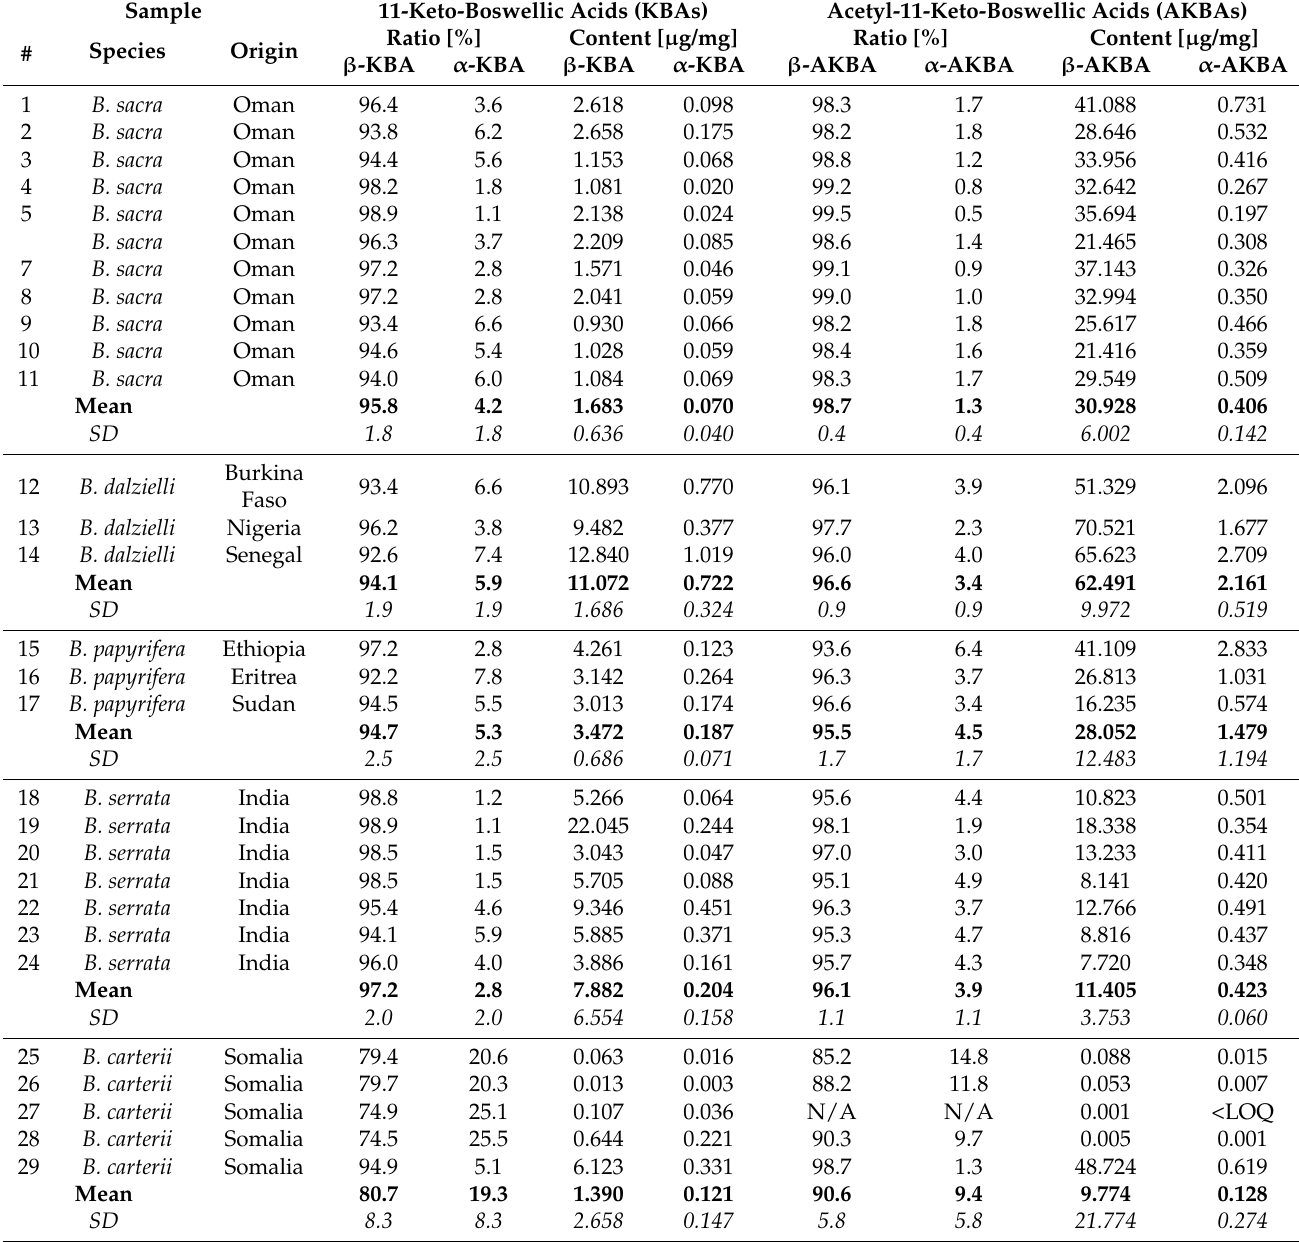
Table 3. Contents of 11-keto- α -boswellic acid ( α -KBA), 11-keto- β -boswellic acid ( β -KBA), acetyl-11-keto- α -boswellic acid ( α -AKBA), and 11-keto- β -boswellic acid ( β -AKBA) in Boswellia oleogum resins. Quantification by high-performance liquid chromatography with tandem mass spectrometry (HPLC-MS/MS) in duplicates. Average values of respective species are expressed as mean ± standard deviation (SD); contents below the limit of quantification as